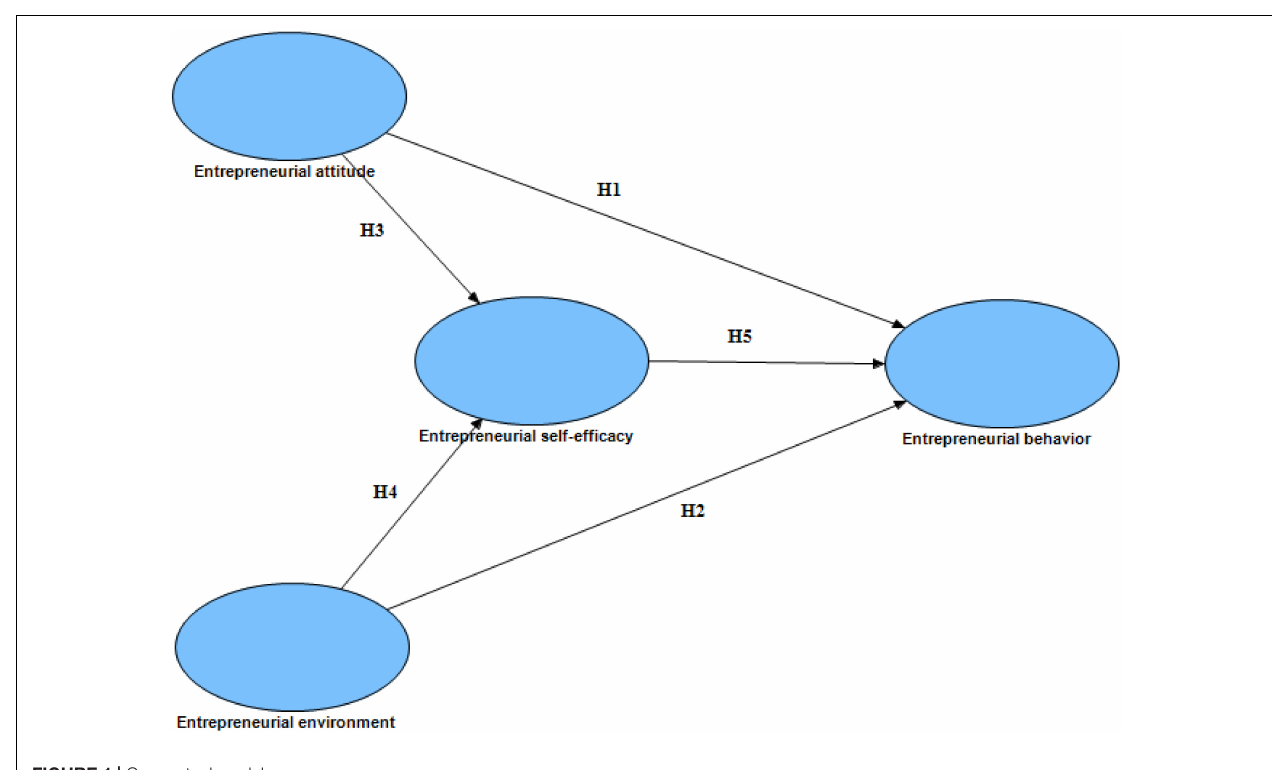
FIGURE 1 | Conceptual model. TABLE 1 | Distribution of questionnaires on entrepreneurship of rural farmers in the five western